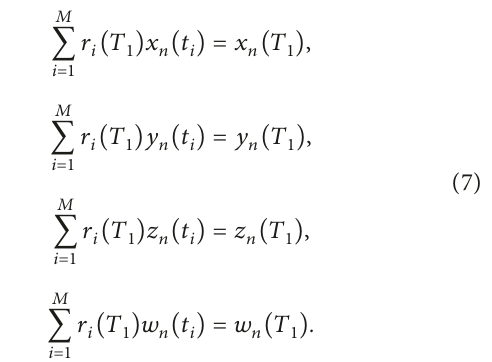
) on x − y − w plane; ( c 3